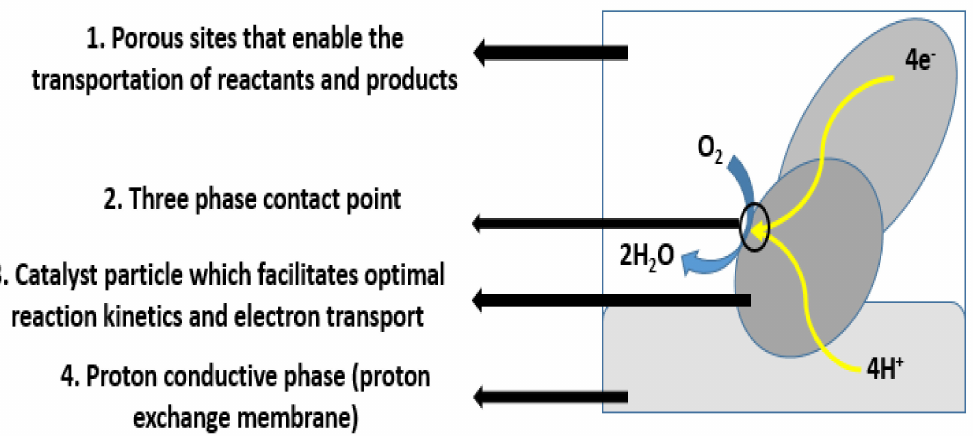
Figure 5. Schematic representation of the three-phase contact boundary for the cathode’s catalyst layer in a DMFC adapted from